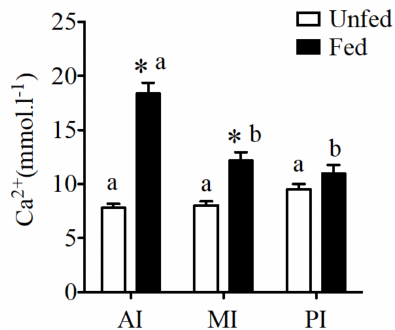
Figure 2. Regional calcium concentration (mmol · L − 1 ) in anterior intestine (AI), mid intestine (MI), and rectum in fluids of sea bream collected from unfed and fed fish sampled 6 h after feeding. Results are shown as mean ± SE ( n = 8–10); differences among groups were evaluated by two-way ANOVA (followed by a Bonferroni post-hoc test), with feeding conditions and intestinal segment as independent variables within feeding groups different letters represent significantly different levels, between the same regions, * represents significant effects p <